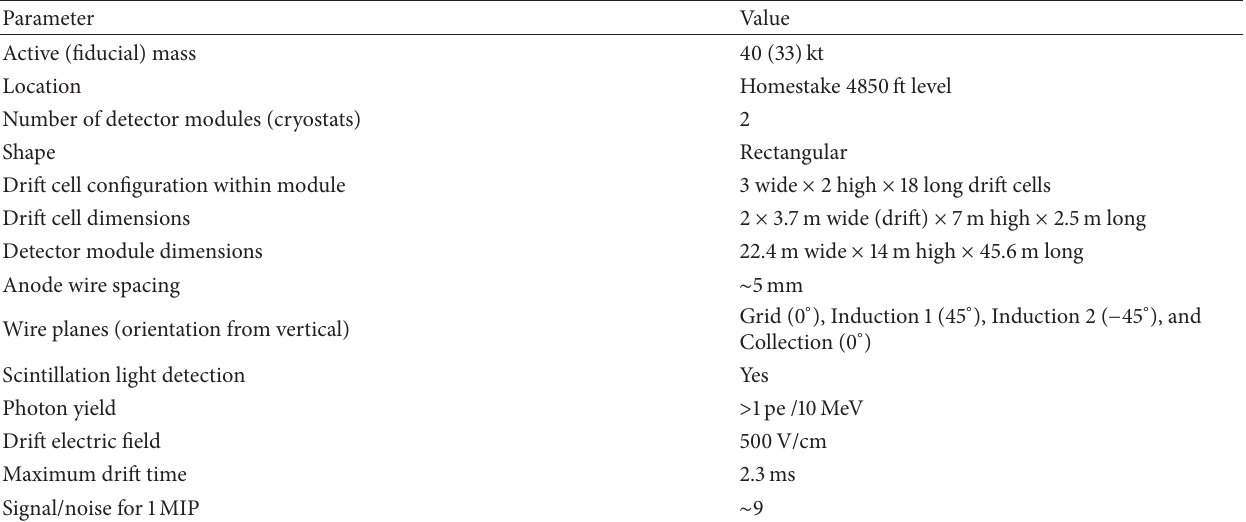
Table 2: LAr-FD principal